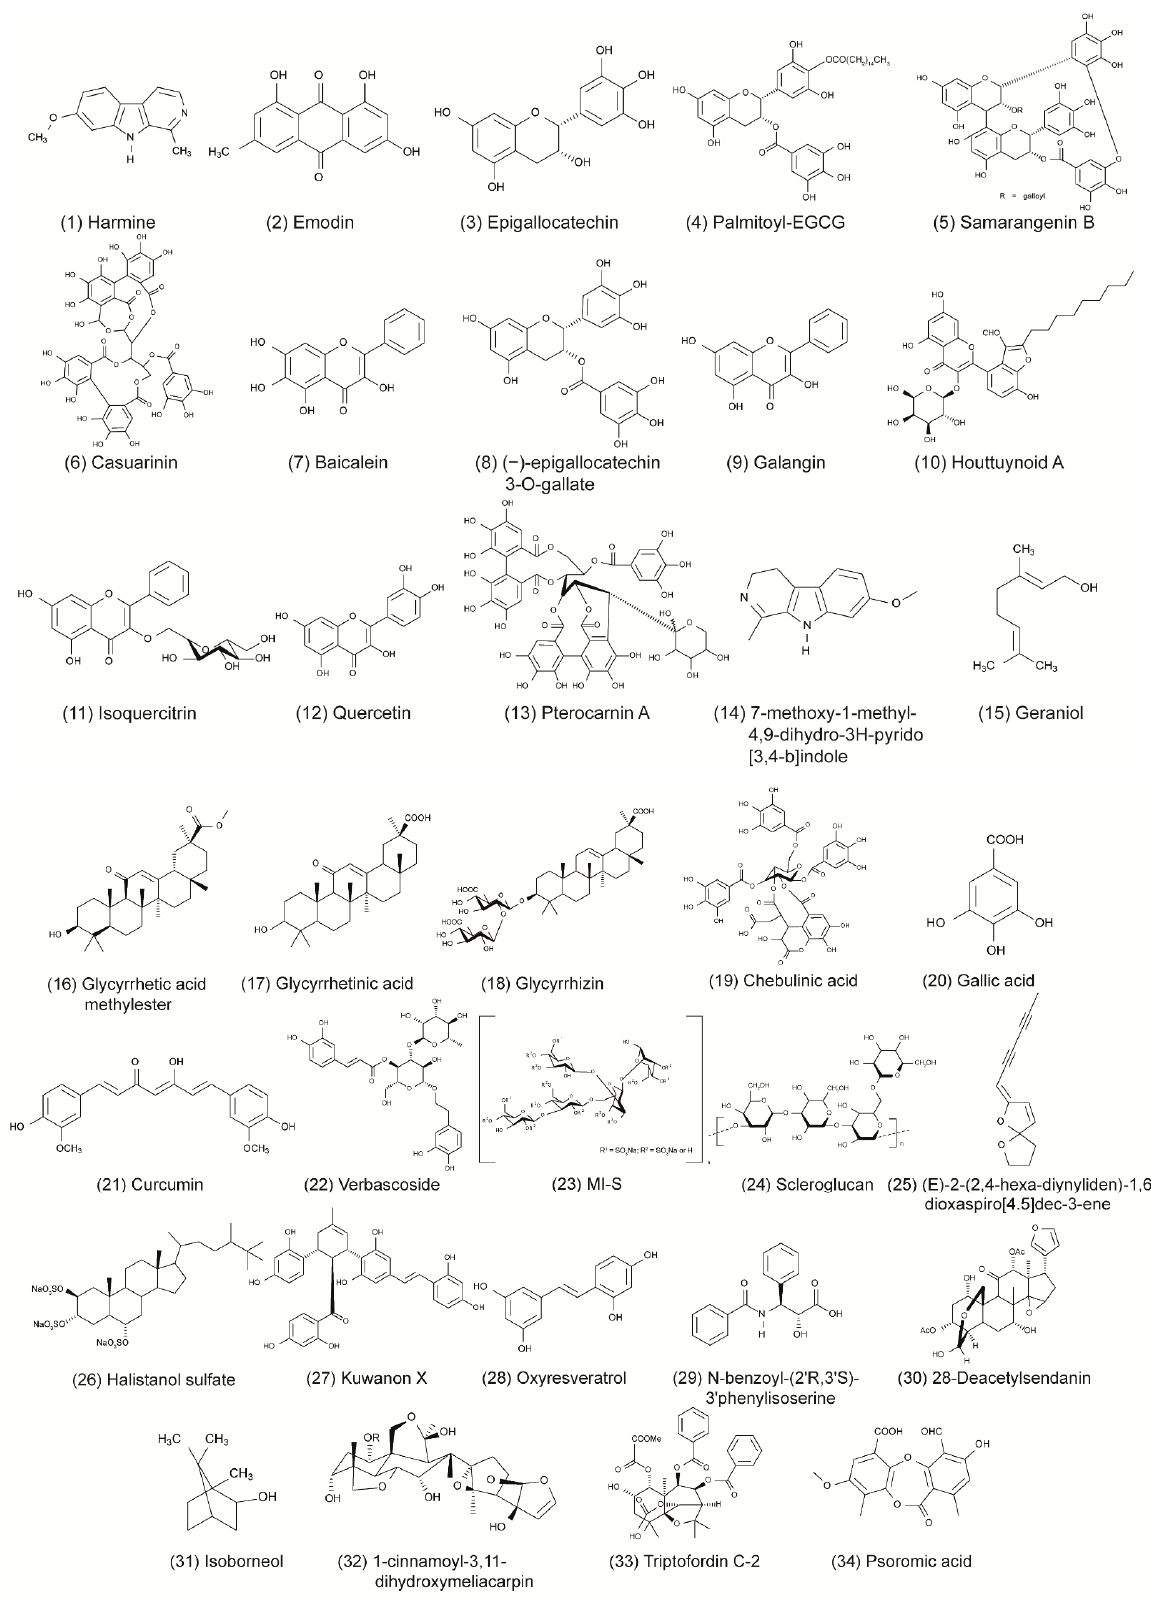
Figure 2. Chemical structures of distinct compounds with antiviral activity against herpes simplex viruses, which were isolated from natural sources. Enumeration is consistent with Table 1, where the characteristics of the compounds are summarized in greater detail.